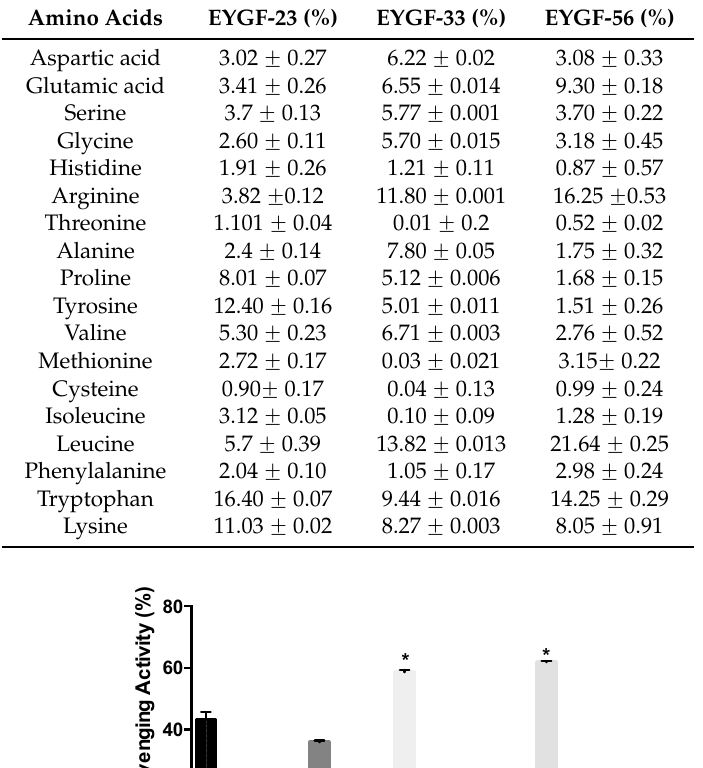
Table 2 . Amino acid composition of EYGF-23, EYGF-33 and EYGF-56 fractions. Data correspond to the means ± SD of three independent experiments.